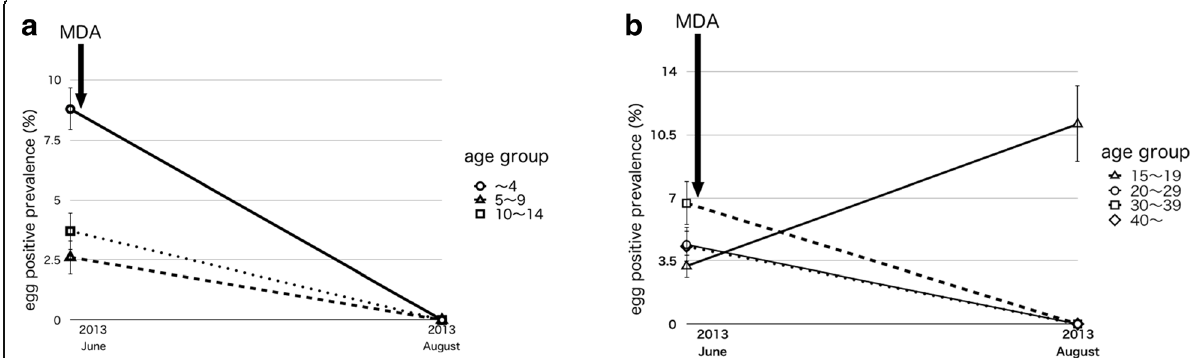
Fig. 4 a Process of egg-positive rate by age group 2013. b Process of egg-positive rate by age group